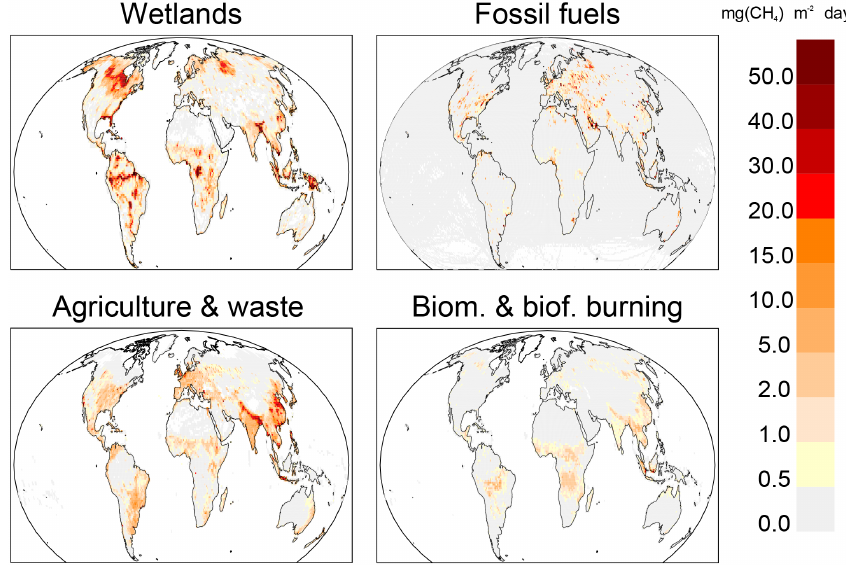
Figure 3. Methane emissions from four source categories: natural wetlands, fossil fuels, agriculture and waste, and biomass and biofuel burning for the 2003–2012 decade in mgCH 4 m − 2 day − 1 . The wetland emission map represents the mean daily emission average over the 11 biogeochemical models listed in Table 1 and over the 2003–2012 decade. Fossil fuel and agriculture and waste emission maps are derived from the mean estimates of EDGARv4.2FT2010 and GAINS models. The biomass and biofuel burning map results from the mean of the biomass burning inventories listed in Table 1 added to the mean of the biofuel estimate from EDGARv4.2FT2010 and GAINS